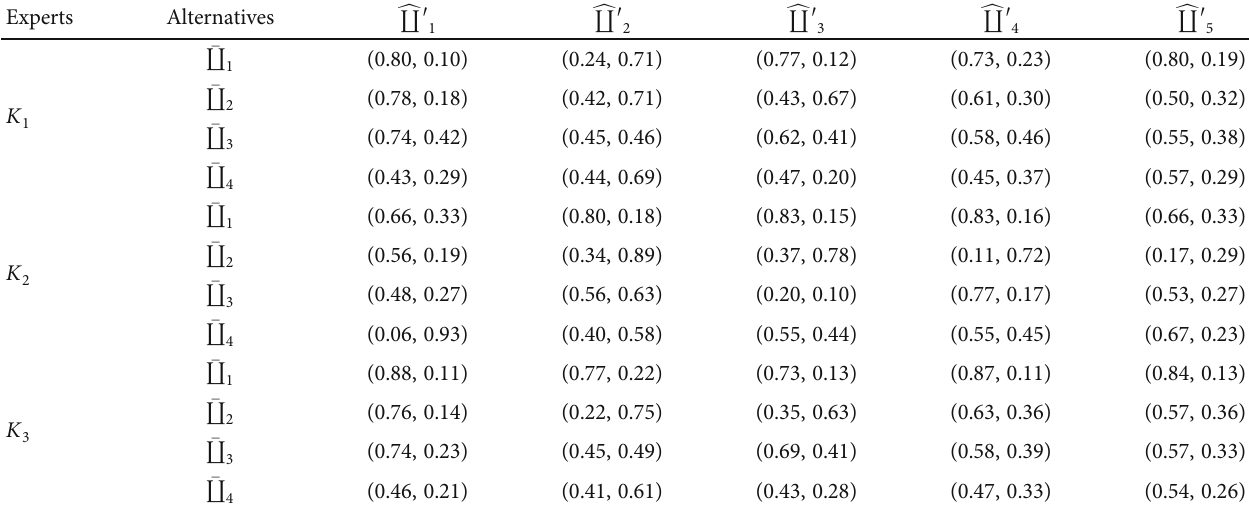
Table 1: Rating given by DMs.